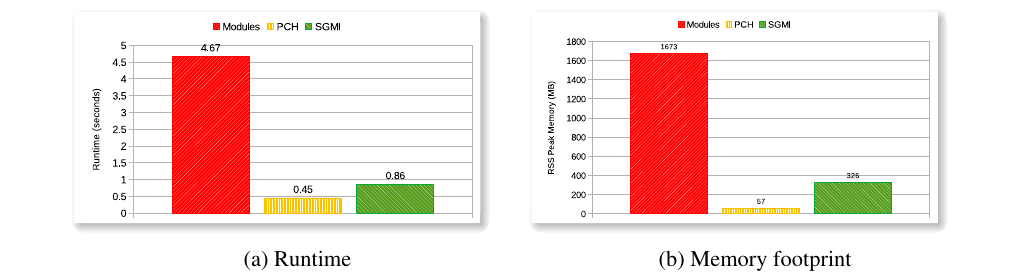
Figure 2: Performance benchmarks of root.exe -l -b -q in